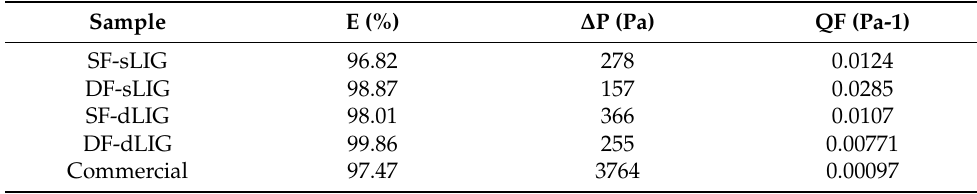
Figure 5. Results of PM 2.5 removal testing. ( a ) PM 2.5 concentrations measured in the downstream chamber for several cases: ( i ) diluted incense flow without filter, ( ii ) unbiased DF-dLIG filter (0 V) with ionizer off (0 V), ( iii ) unbiased DF-dLIG filter with ionizer activated; ( b ) PM 2.5 concentrations for biased (12 V) SF-sLIG, SF-dLIG, DF-sLIG, and DF-dLIG filters with ionizer on (enlarged part of ( a ) in the range 0–40 µg/m 3 ); ( c ) PM 2.5 removal efficiency of different filters with different voltages applied to LIG. Table 1. Filtration performance summaries for different filter